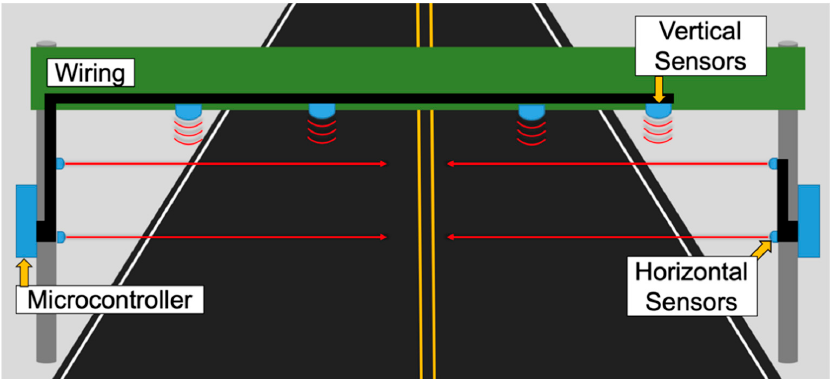
Figure 1. System setup overview for the proposed overheight sensor network.